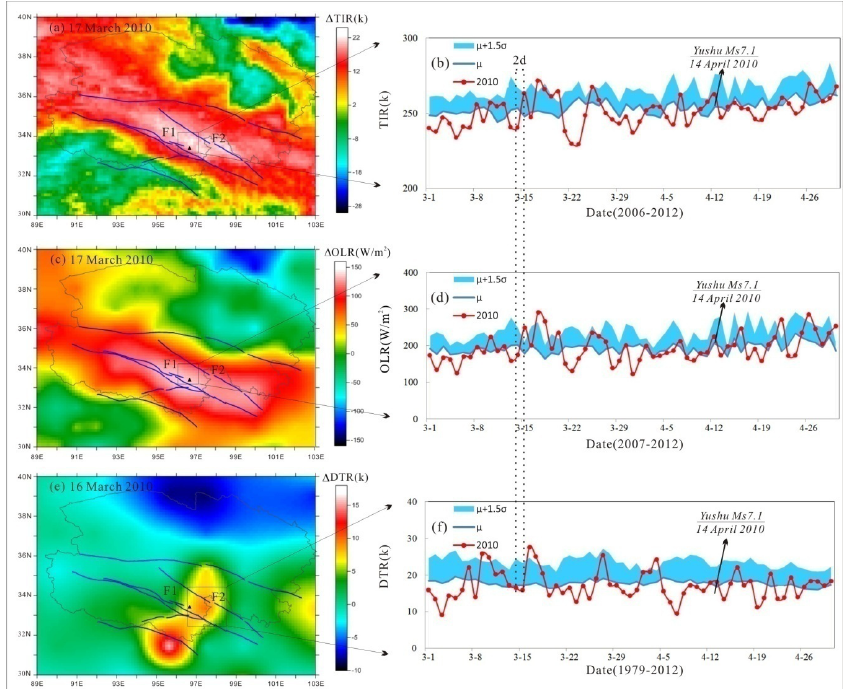
Figure 3. ( a ) Spatial distribution of differential thermal infrared radiation ( ∆ TIR ) on 17 March 2010, obtained by subtracting 6 years (2006–2012, excluding 2010) mean of FengYun satellite, Visible and Infrared Spin Scan Radiometer (FY-VISSR) TIR from the data of 2010. ( b ) Time series of TIR in the epicenter pixel group (33°N–34°N, 96°E–97°E) of the Yushu earthquake. ( c ) Spatial distribution of differential outgoing longwave radiation ( ∆ OLR ) on 17 March 2010, obtained by subtracting 5 years (2007–2012, excluding 2010) mean of NOAA-AVHRR night OLR from the data of 2010. ( d ) Time series of OLR in the epicenter pixel group (33°N–34°N, 96°E–97°E) of the Yushu earthquake. ( e ) Spatial distribution of differential diurnal temperature range ( ∆ DTR ) on 16 March 2010, obtained by subtracting 33 years (1979–2012, excluding 2010) mean of National Center for Environmental Prediction/National Center for Atmospheric Research (NCEP/NCAR) Reanalysis DTR from the data of 2010. ( f ) Time series of DTR in the epicenter pixel (33.3328°N, 97.5°E) of the Yushu earthquake. The black triangles indicate the epicenter. F1 and F2 indicate Ganzi-Yushu Fault and Qingshuihe Fault,